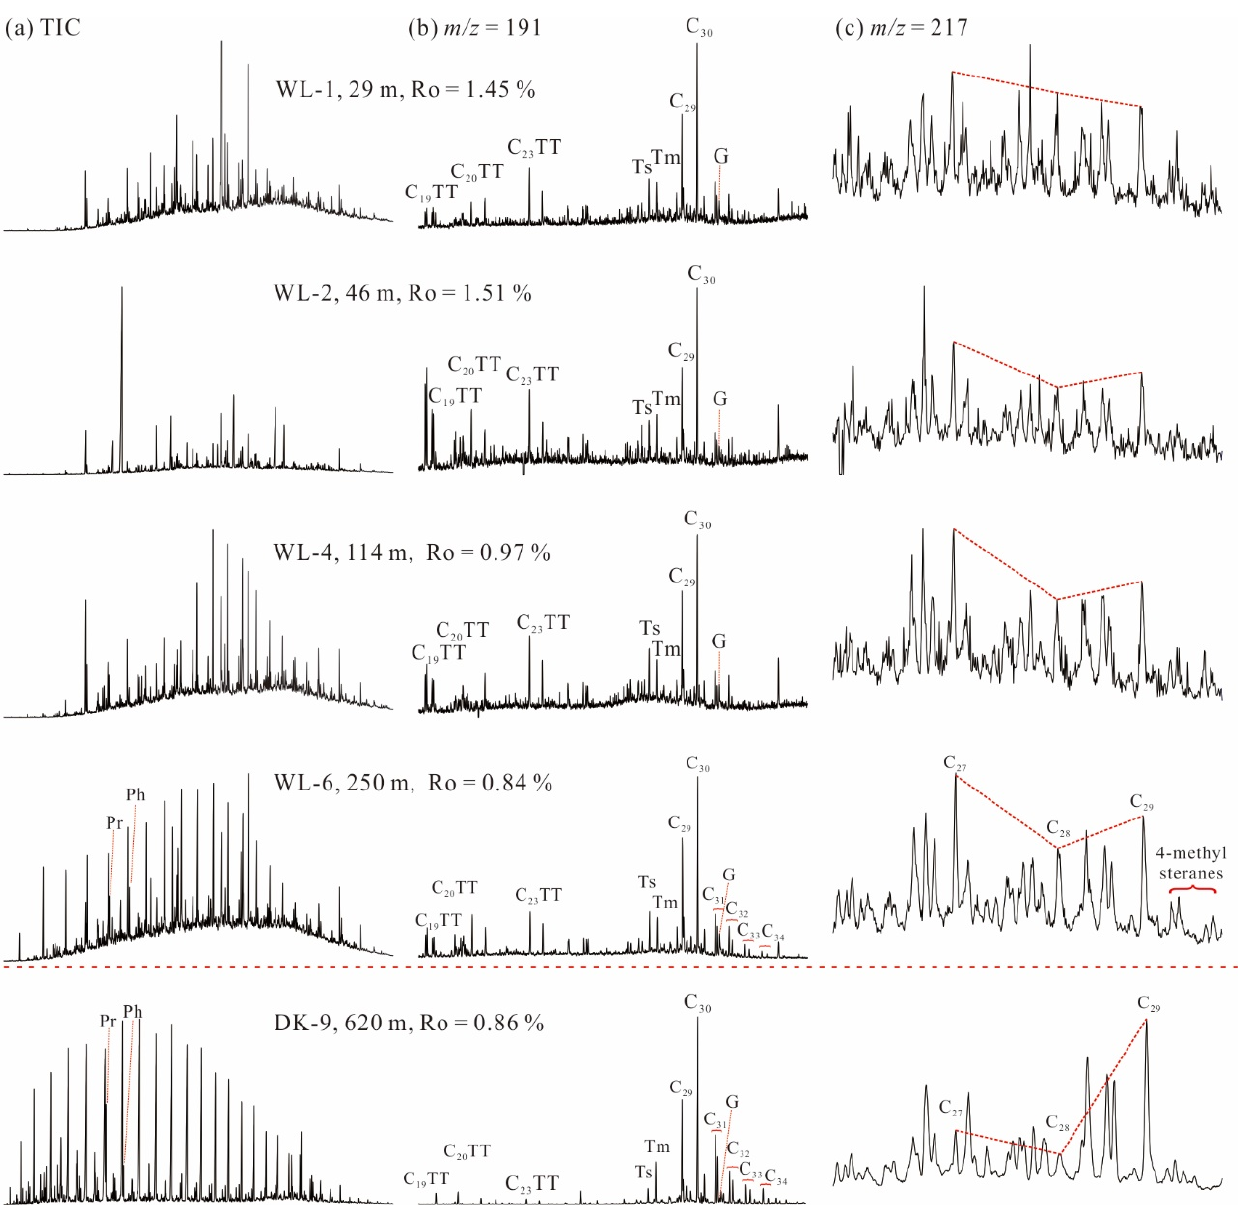
Figure 3. ( a ) Total ion chromatogram (TIC), ( b ) m/z = 191 and ( c ) m/z = 217 mass chromatograms of saturated hydrocarbon fractions from WL and DK samples.